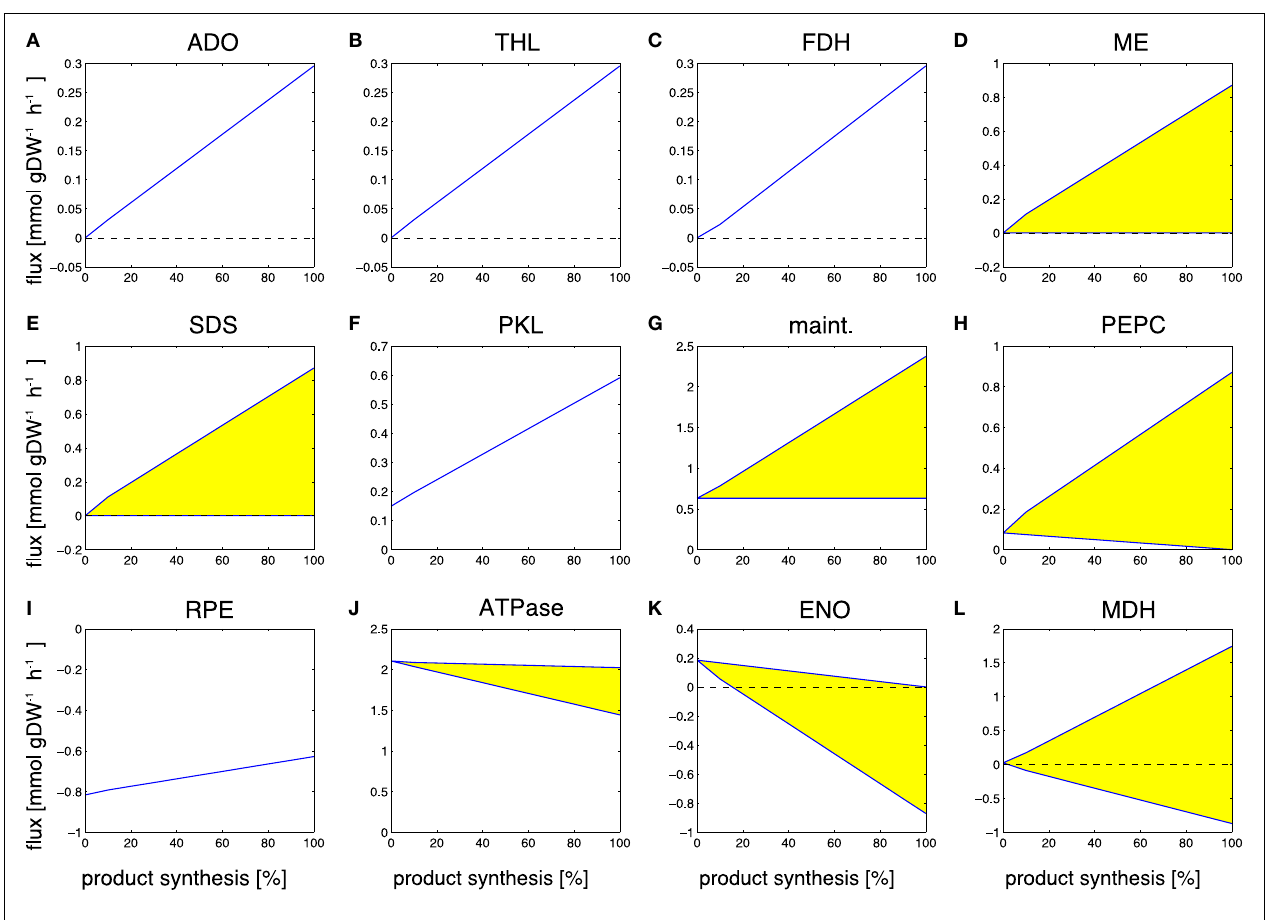
FIGURE 7 | Examples of predicted reaction fluxes during the transition from a growth-only phenotype to a production-only phenotype for propane . Yellow areas indicate flux variability. Abbreviations: (A) ADO, aldehyde deformylating oxygenase; (B) THL, thiolase; (C) FDH, formate dehydrogenase;